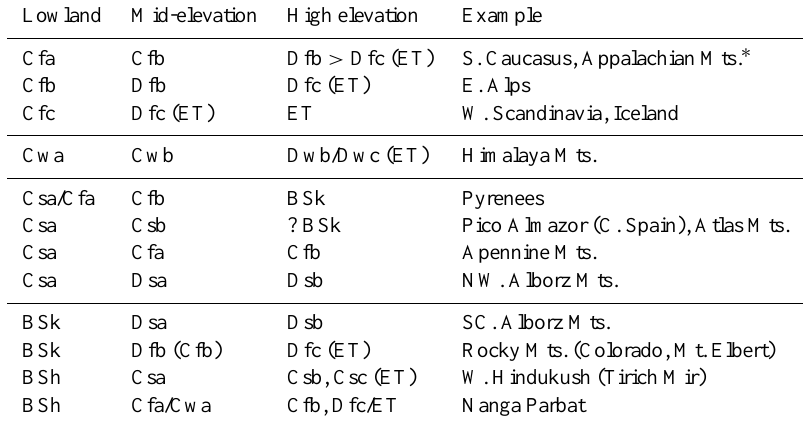
Table 5. Vertical progression of Köppen climate types in Northern Hemisphere mountain